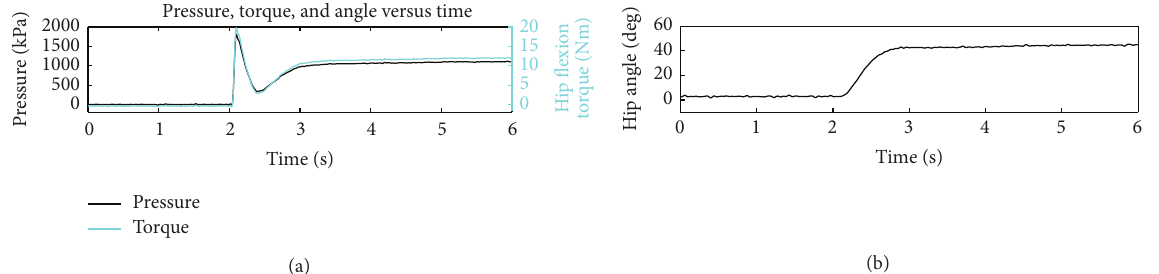
Figure 5: Cylinder pressure differential and torque change (a) during isokinetic (120 ∘ /s) movement of the hip (b). Power assist was activated at time = 2 seconds.